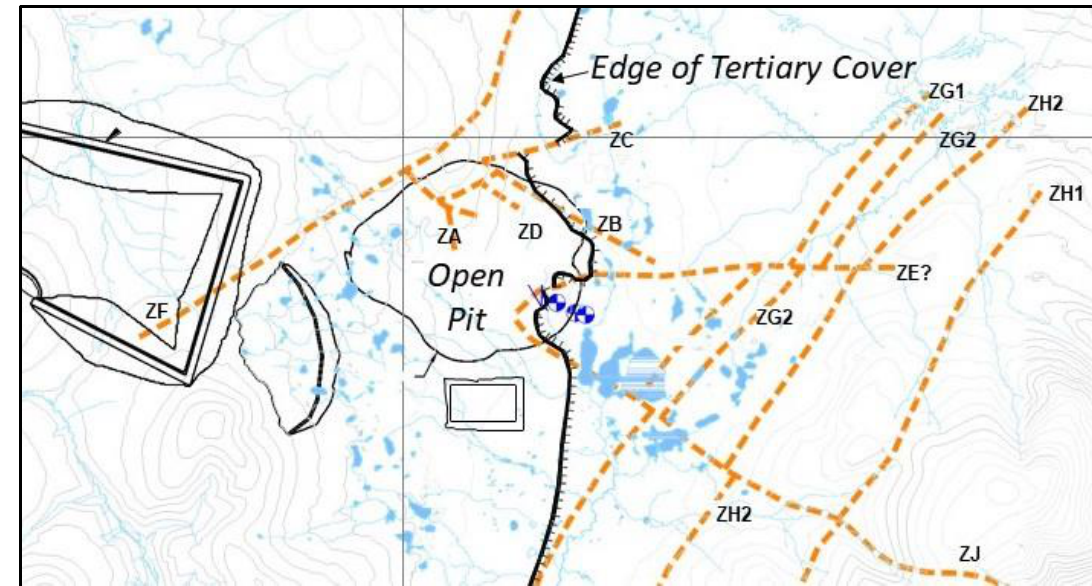
Figure 2. Plan view showing identified and named faults (dashed orange) on and near the mine site, including through the open pit. Black hatched line is the edge of Tertiary cover, showing that only limited sections on the east side of the pit contain Tertiary rocks, and all other areas of the pit contain Pre-Tertiary rocks. Source: Modified from [27] (Figure 2).